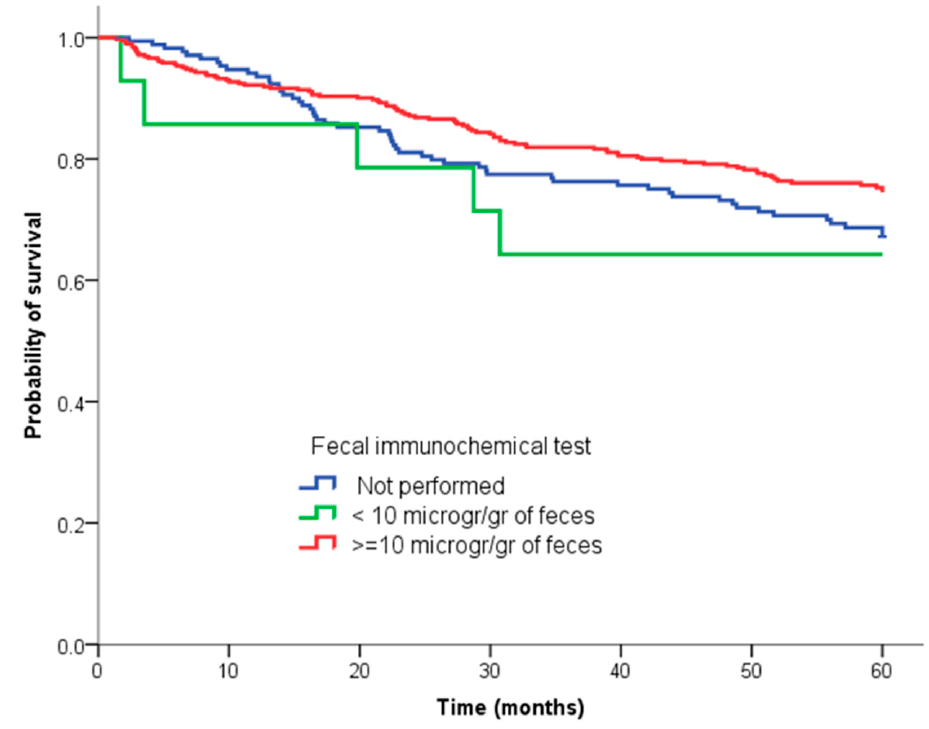
Figure 1. Survival curve of three cohorts calculated with Kaplan–Meier method.